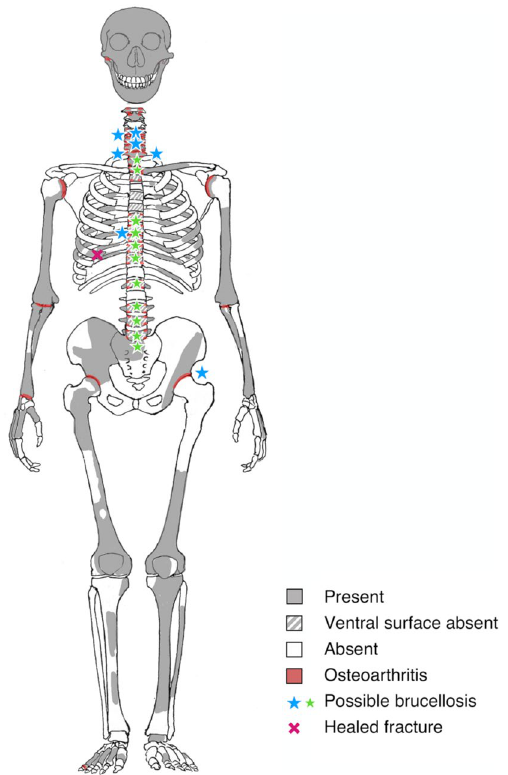
Figure 1. Preservation of the La Chapelle-aux-Saints 1 Neanderthal skeleton and distribution of the pathological lesions. Possible brucellosis leading to erosions affected the inferior endplates of vertebrae C5 and C6, the right facet joints C4/5 and C7/T1, the left transverse process T1, both facet joints T9/10, and the left hip bone (blue stars). Irregular grooves likely associated with granulomateous processes are found on the laminae of thoracolumbar vertebrae (green stars). Osteoarthritic changes (red) are present in the right temporomandibular joint, the facet joints of the vertebral column, glenohumeral joints, left sternoclavicular joint, elbow joints, right radiocarpal joint, hip joints and right fifth pedal proximal interphalangeal joint. A midthoracic right rib shows a healed fracture (cross).